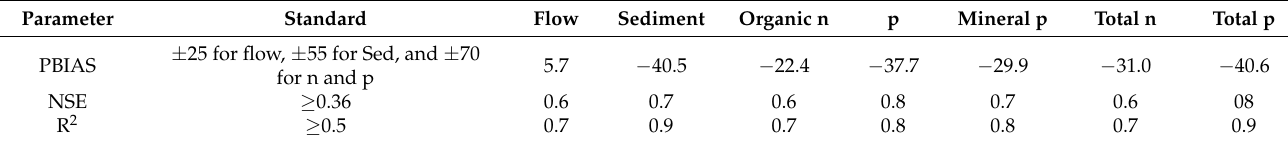
Table 2. Evaluation criteria: